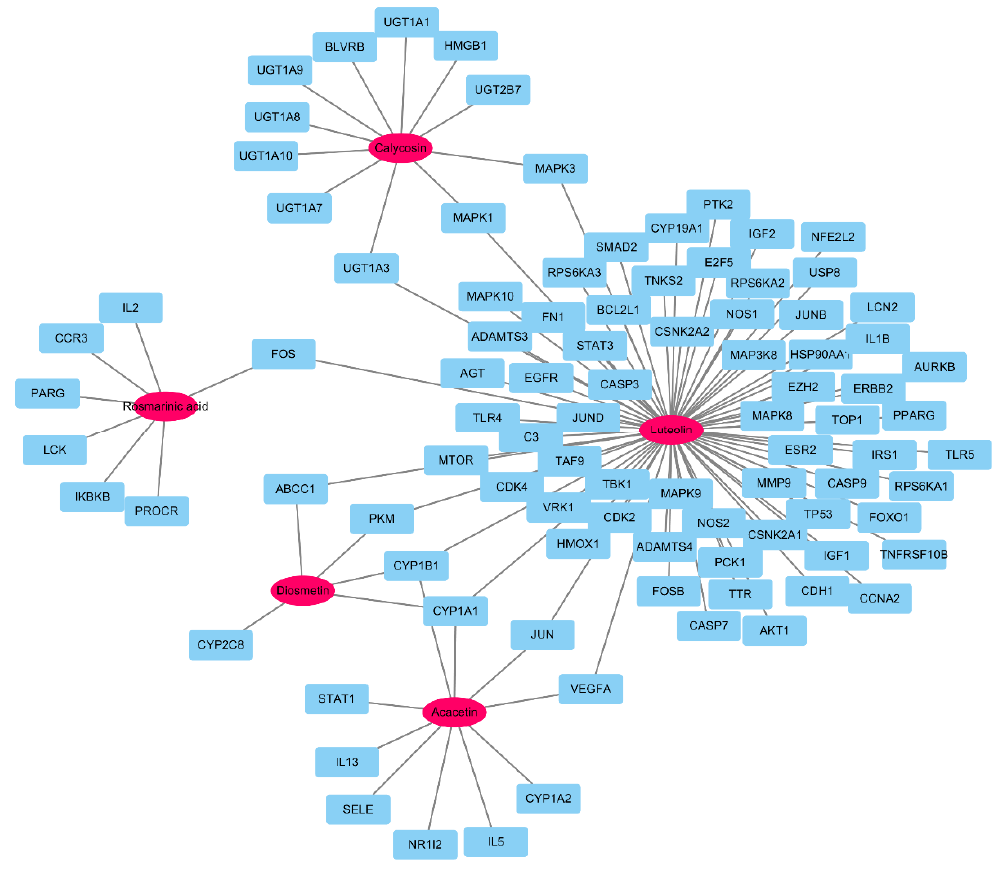
Figure 5. Network of five components (pink oval) and 93 target genes (sky-blue square): this network was comprised of 98 nodes and 105 edges, and luteolin was the most important node because of high score of degree, betweenness centrality, and closeness centrality in this network.